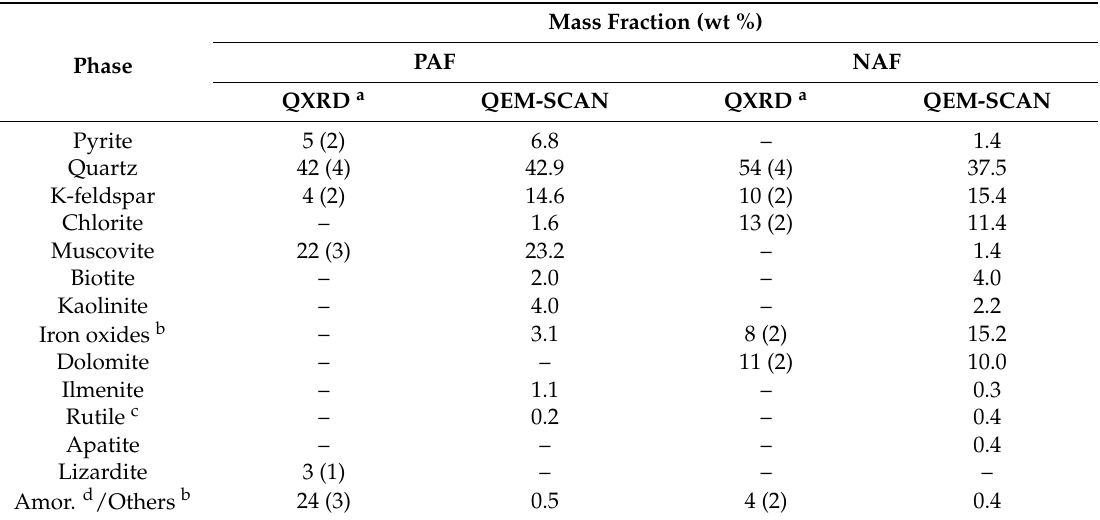
Table 2. Mineralogical composition of the PAF and NAF